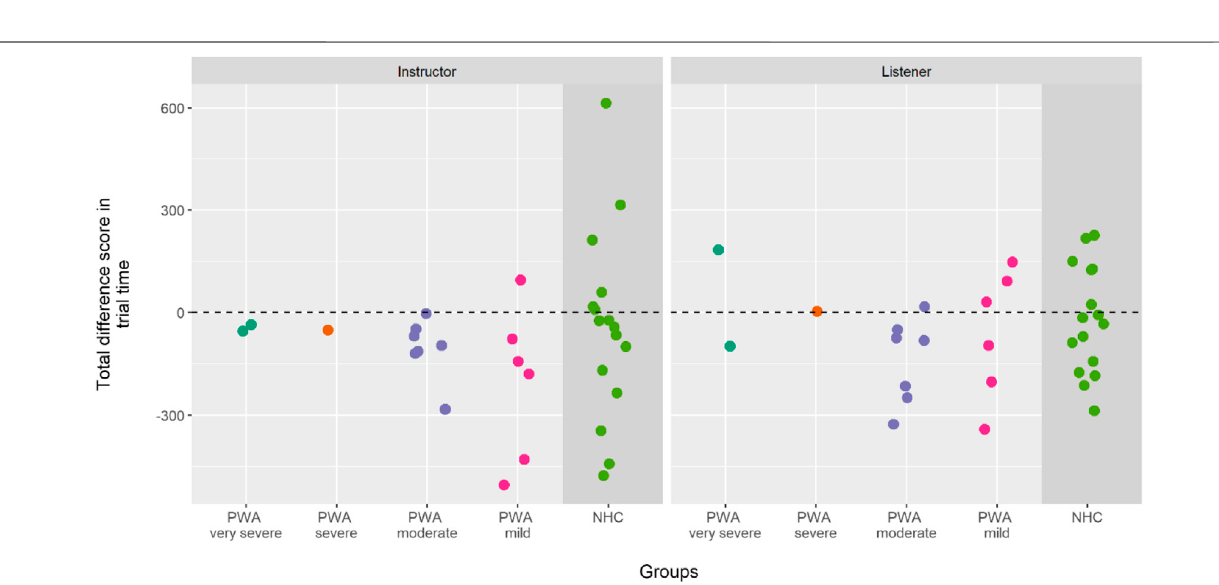
FIGURE 4 | Plot showing individual data points for both groups for difference score between familiar and unfamiliar conditions, by role (PWA grouped by WAB categorization). Zero representsno change in total trial time between conditions, negative values indicate ashorter total trial time in the unfamiliar condition compared to the familiar